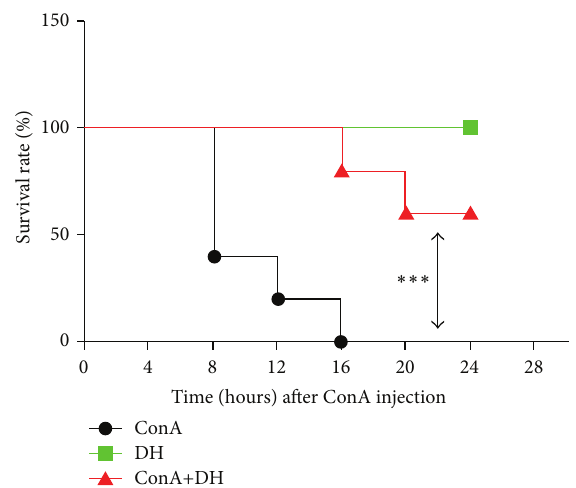
Figure 1: DH protects against ConA-induced acute hepatitis. Notes: female BALB/c mice ( 𝑛 = 10 ) were injected i.p . with DH (20 mg/kg body weight) at 2 h before the injection of a lethal dose of ConA (30 mg/kg) i.v . The survival rate was monitored at different times after ConA administration, with the data expressed as the mean ± SD ( 𝑛 = 10 ; ∗∗∗ 𝑃 < 0.001 for ConA versus ConA+DH). ConA: Concanavalin A; DH: Dracocephalum heterophyllum